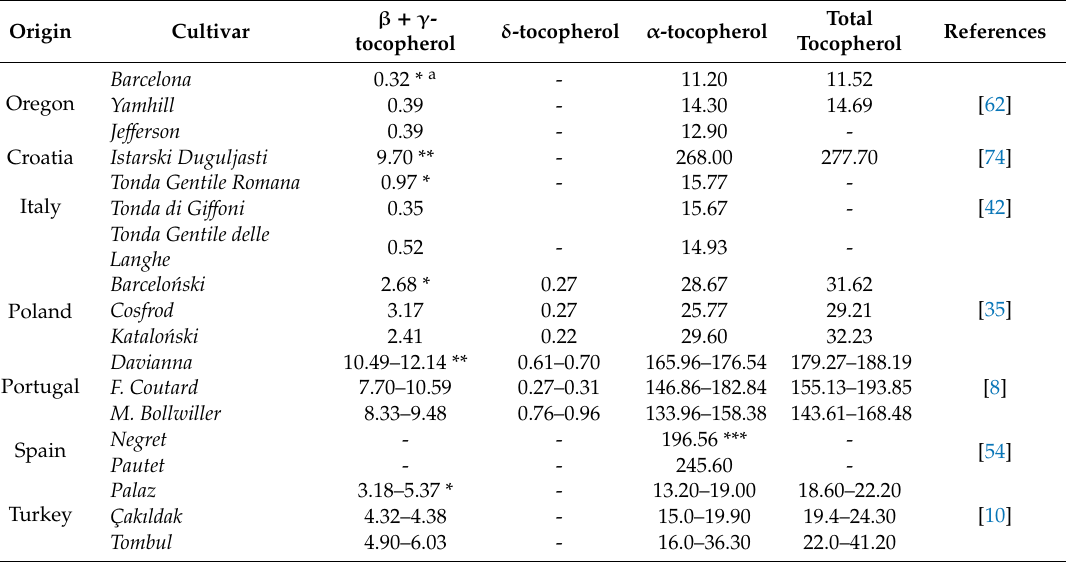
Table 3. Tocopherol homologue concentration in hazelnut oil from di ff erent cultivars and origins.